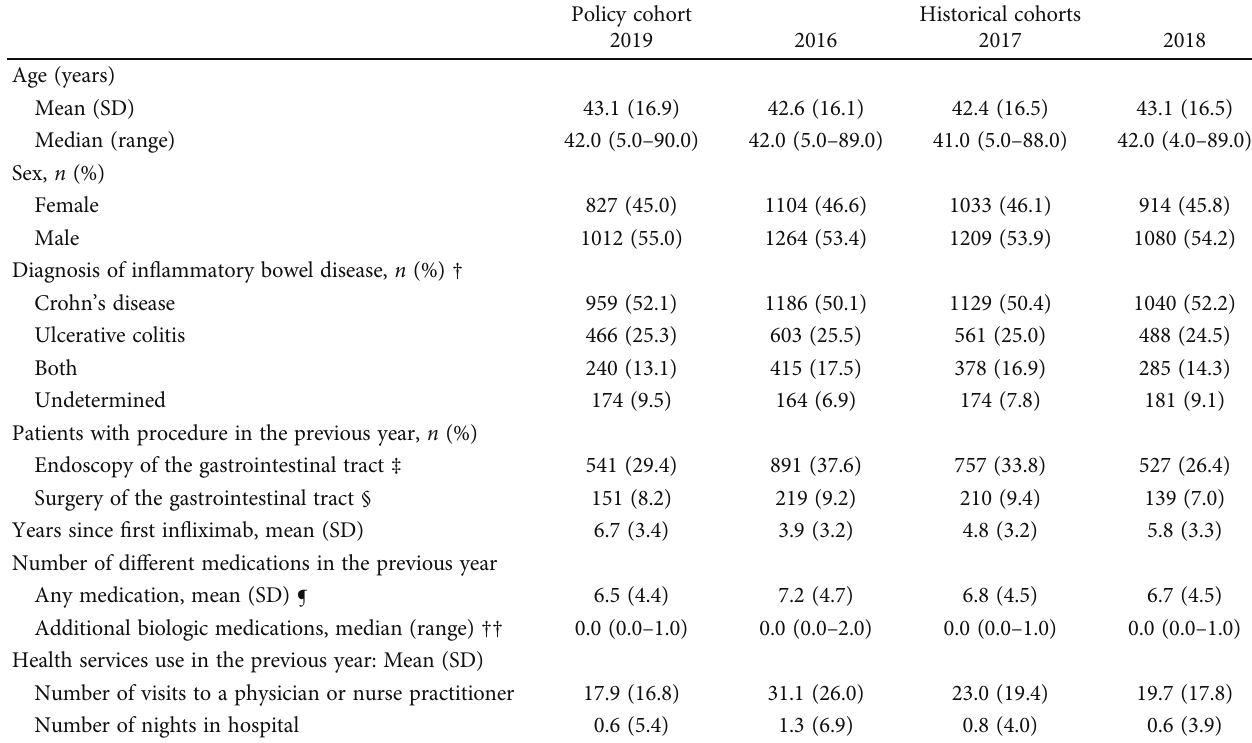
Table 2: Patient characteristics for the policy cohort and the three historical